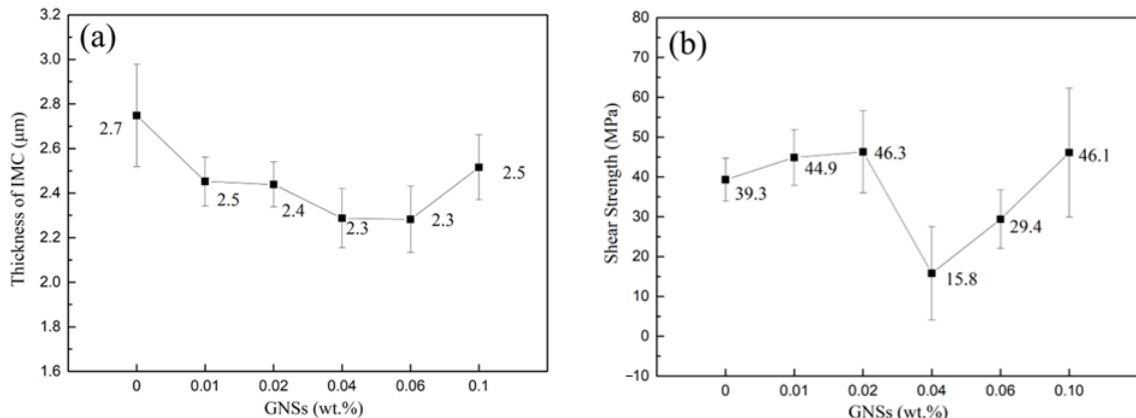
Figure 5. ( a ) Thickness of the IMC layer formed at MC Sn-20Bi- q GNSs/Cu and ( b ) shear strength of MC Sn-20Bi- q GNSs/Cu solder